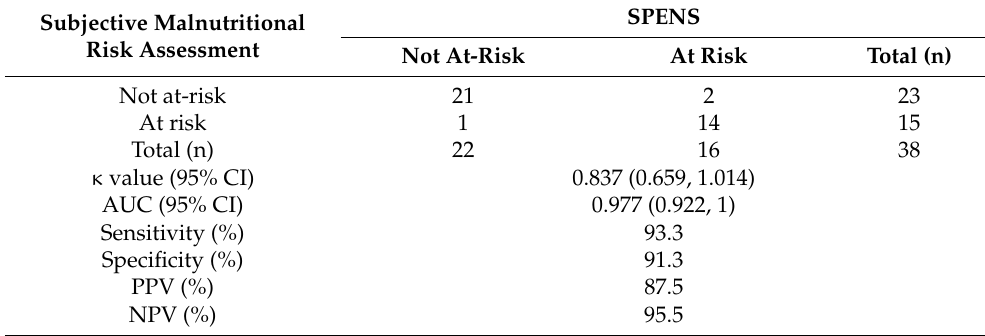
Table 2. Validation of SPENS with the subjective malnutritional risk assessment. Subjective Malnutritional